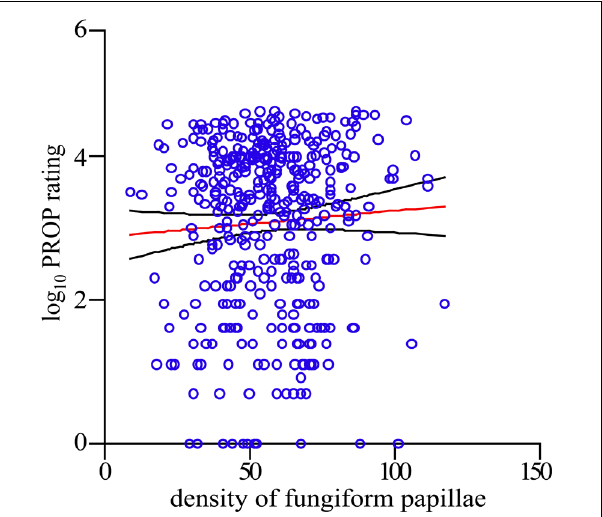
FIGURE 3 | FP density is not predictive of PROP intensity rating. Scatterplot of FP per square centimeter and the logarithm base 10 of PROP. Each o represents one person. Red line indicates the regression of logarithm base 10 of PROP on FP, and the black lines indicate the upper and lower limits of the 95% confidence interval.